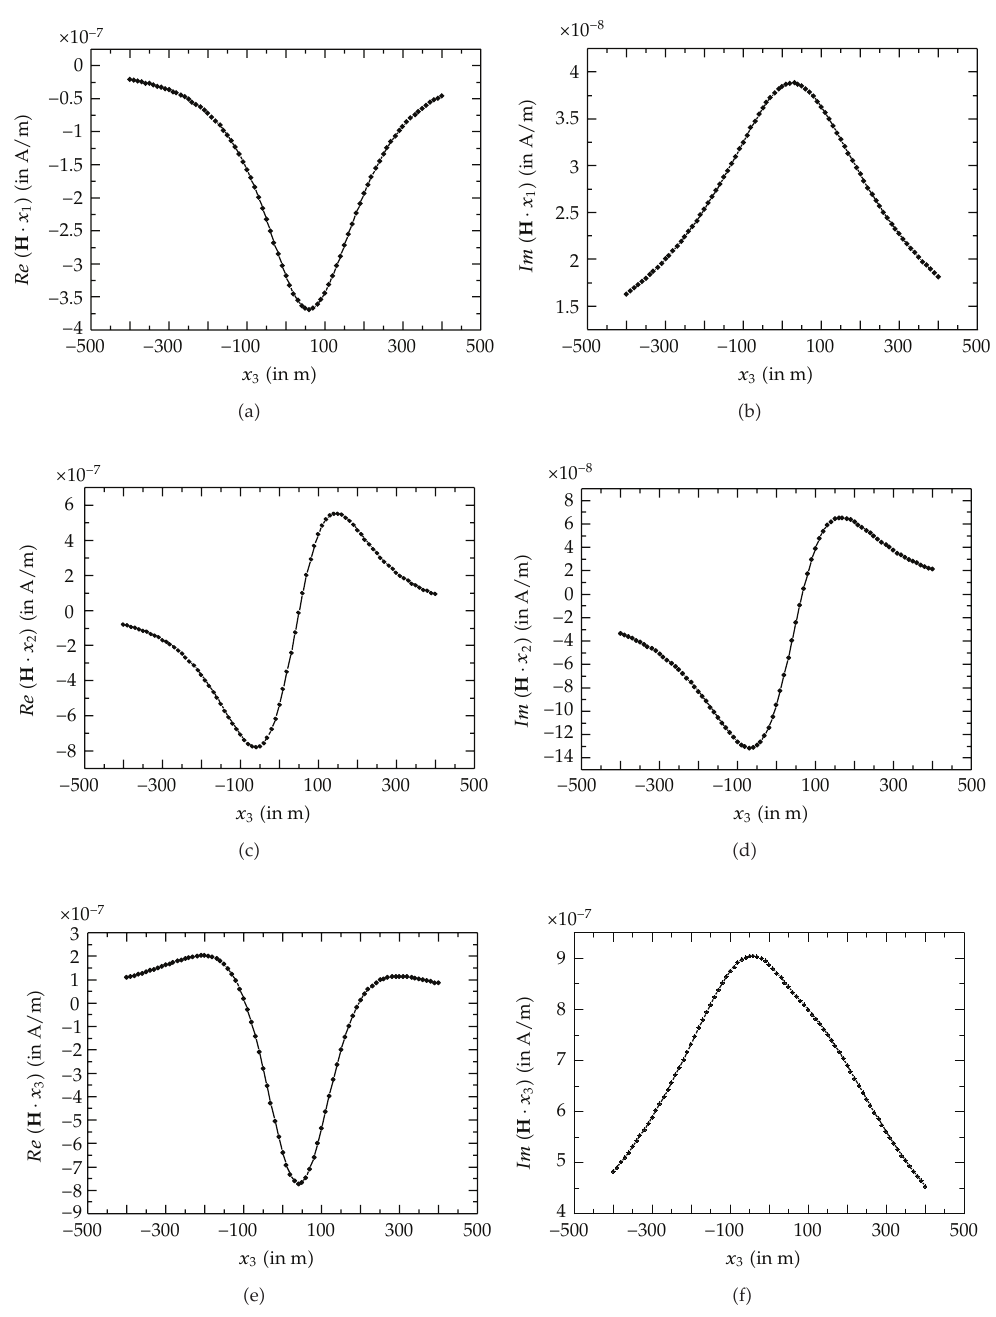
Figure 4: The real and the imaginary parts of the approximated low-frequency scattered magnetic field H for the orders n (cid:4) 0 , 2 , 3. The two spheres have di ff erent radii α 1 (cid:4) 25m and α 2 (cid:4) 50m, while their centers are very close (cid:2) d (cid:4) 76m (cid:3) . The magnetic dipole is located at (cid:2) x 10 ,x 20 ,x 30 (cid:3) (cid:4) (cid:2) 200m , 0m , 0m (cid:3) and the measurement line probe is placed at (cid:2) x 1 p ,x 2 p ,x 3 p (cid:3) (cid:4) (cid:2) 0m , 200m , (cid:6) − 400 , 400 (cid:7) m (cid:3) , obtaining the field on the x 3